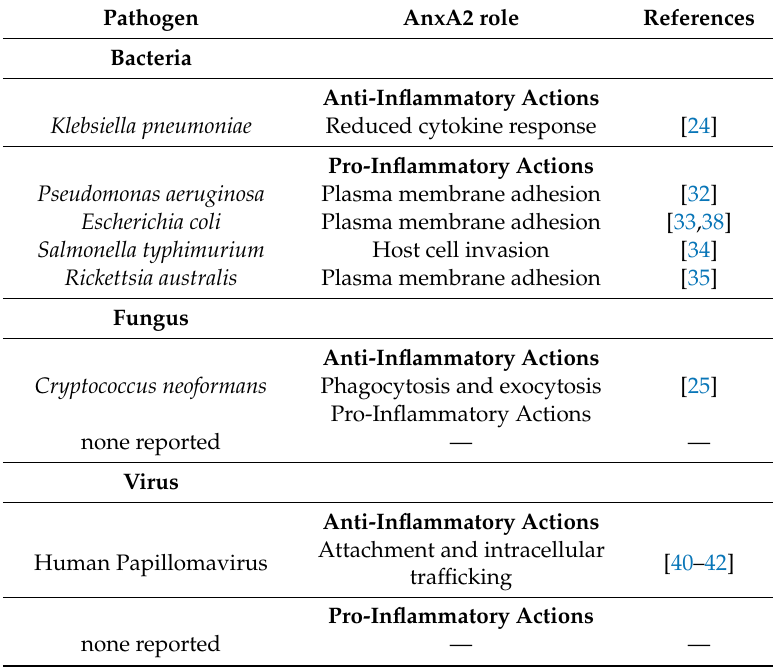
Table 1. Role of annexin A2 in pathogen–host cell interactions in